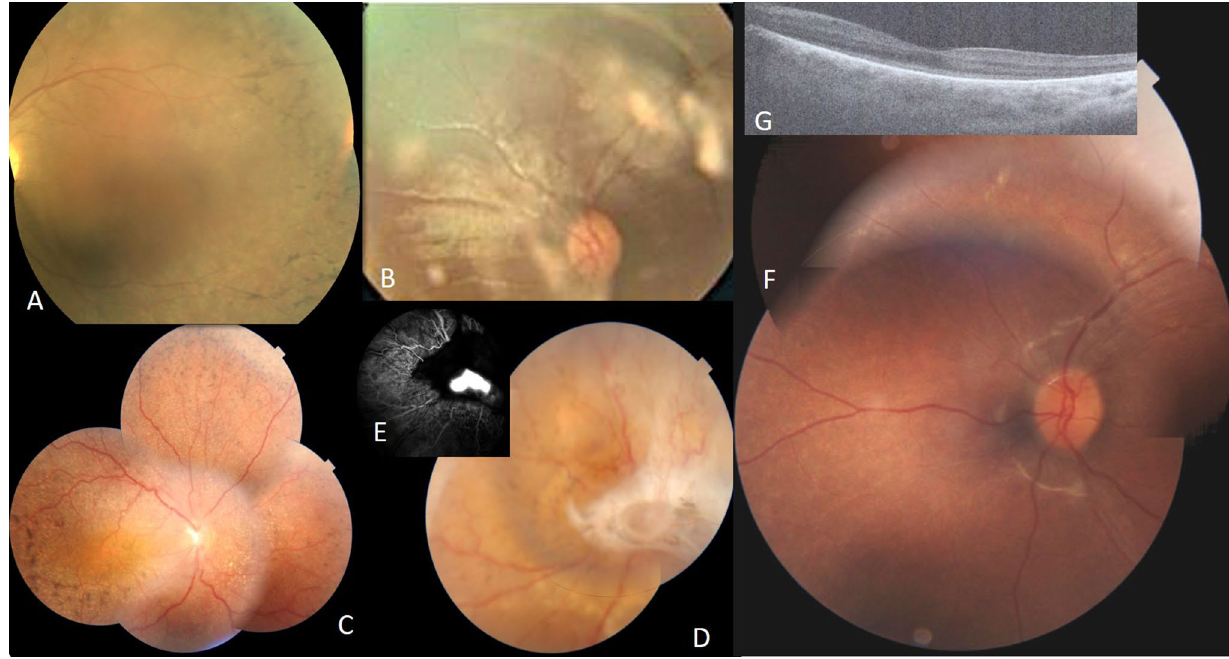
Figure 1. Clinical features of LCA patients; A F1 LE fundus of patient IV.7. B F2 RE fundus of patient II.2. C , D F5 fundus of RLE of patient II.1. E F5 fluorescein angiography of LE of patient III.1 showing noevascular membrane. F F4 LE fundus of patient III.1. G F4 OCT of LE of patient